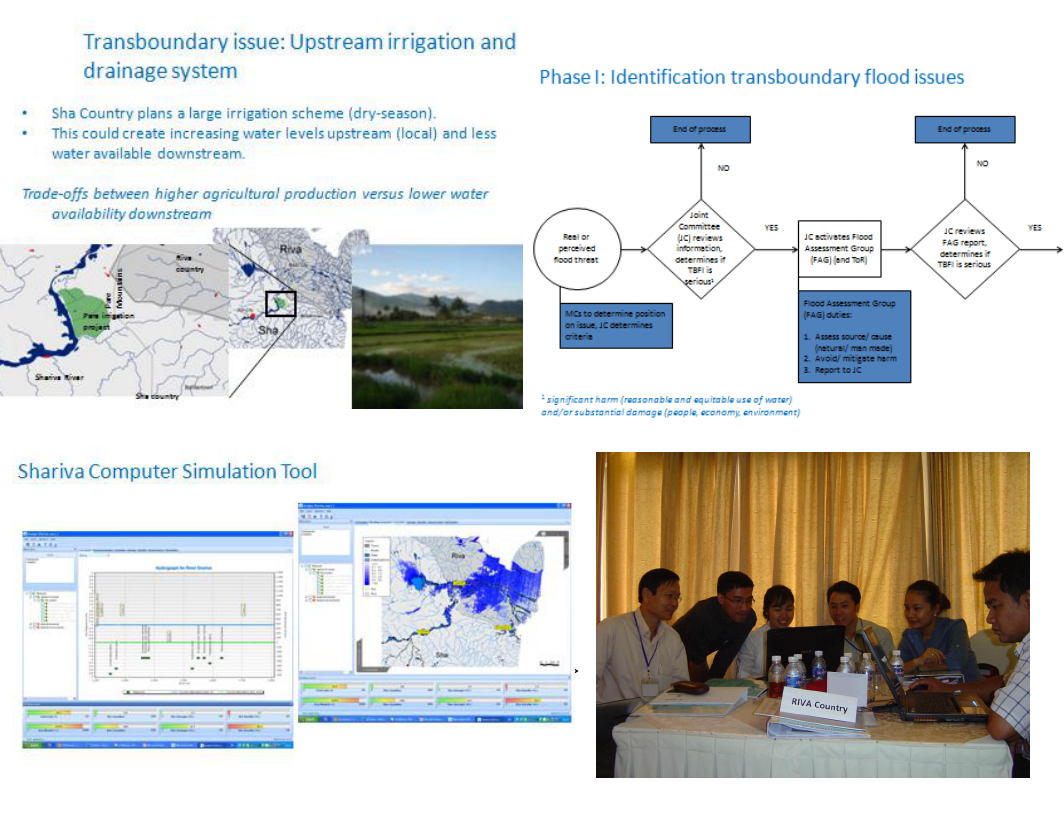
Fig. 1. Pilot Study on addressing and resolving a transboundary issue. Top left: the imaginary transboundary issue, top right: the process of addressing the issue and mandate of institutions (in line with the Mekong Agreement 1995), bottom left: an example of a tool to support the process, and bottom right: simulated negotiations between parties taking